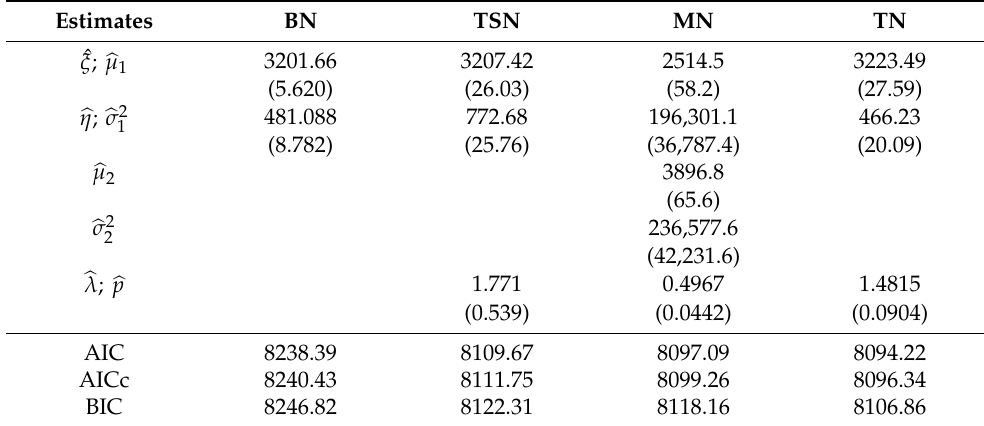
Table 4. MLE for the ultrasound weight data and the corresponding standard errors (in parenthesis), AIC, AICc, and BIC